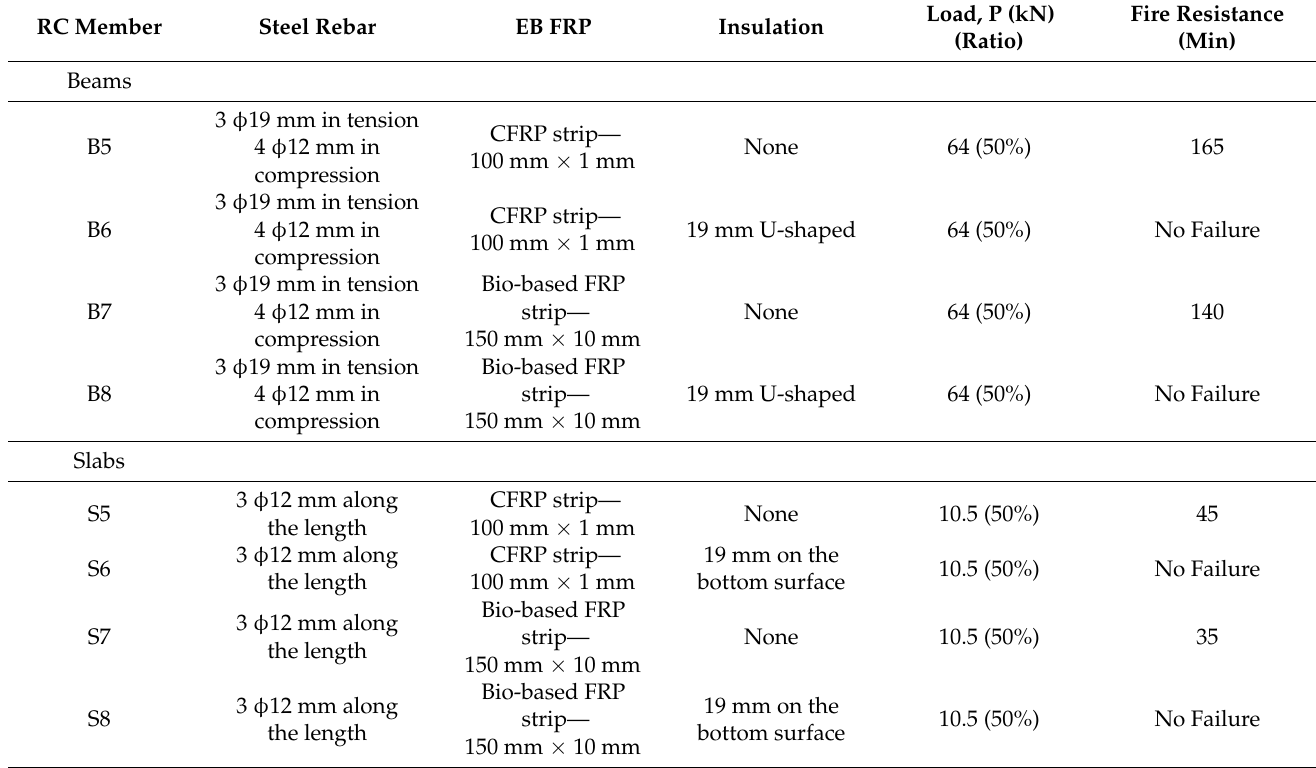
Table 3. Details of RC beams and slabs with EB FRP